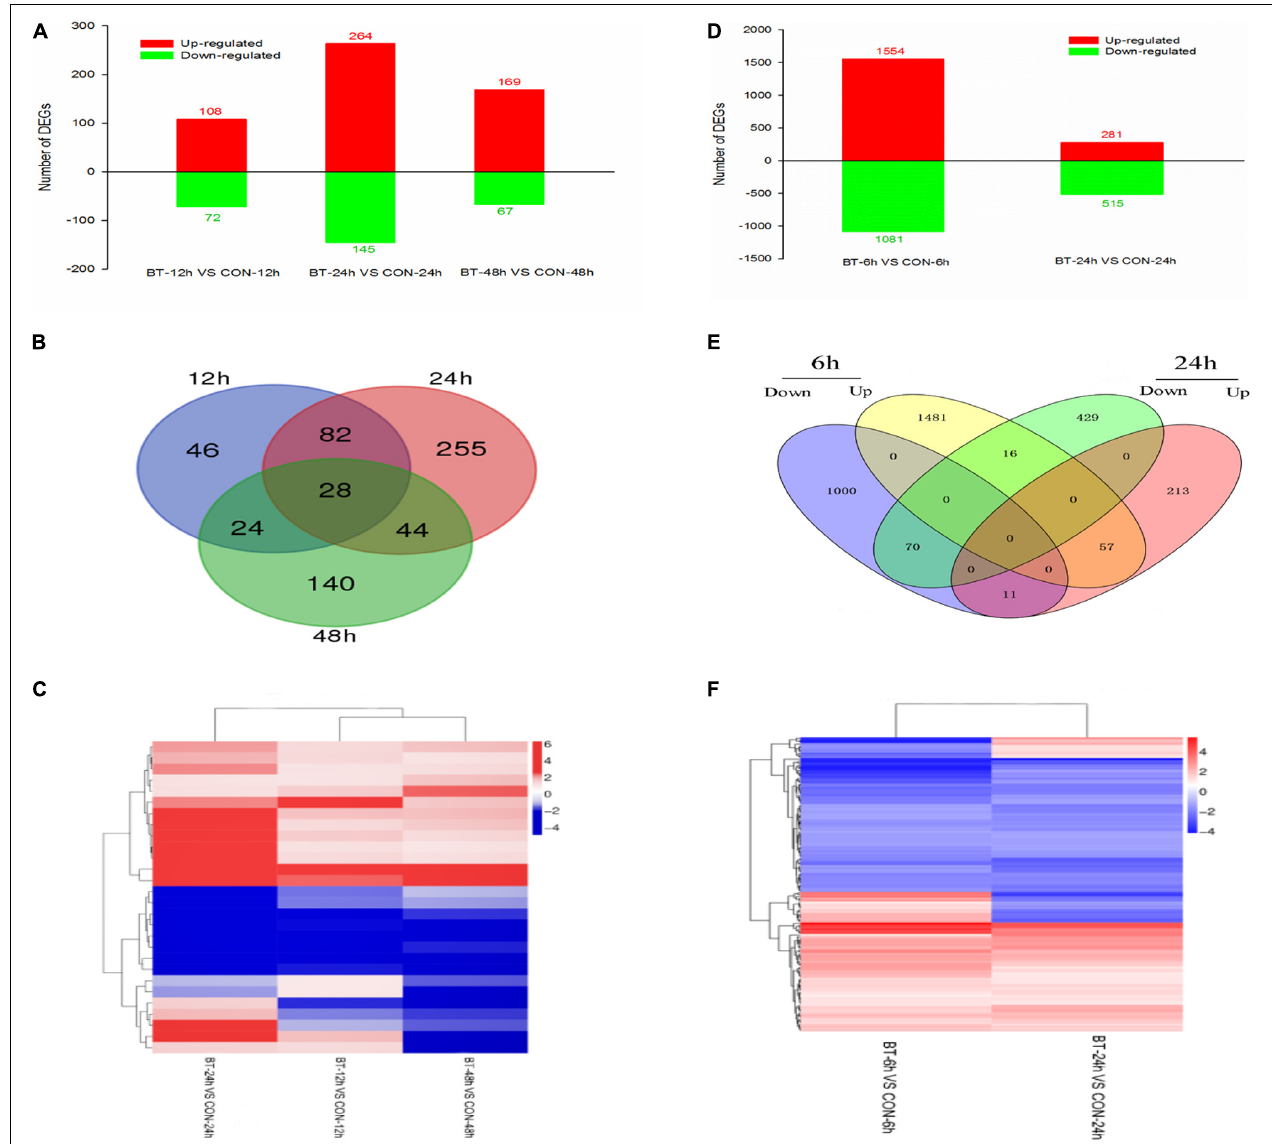
FIGURE 3 | Gene expression profiling of the (A–C) Botrytis cinerea and (D–F) Bradysia odoriphaga transcriptomes. (A,D) Numbers of DEGs in each comparison group. (B,E) Venn diagram showing the shared and specific DEGs (fold change > 2) at each time point. (C,F) Heatmap of common